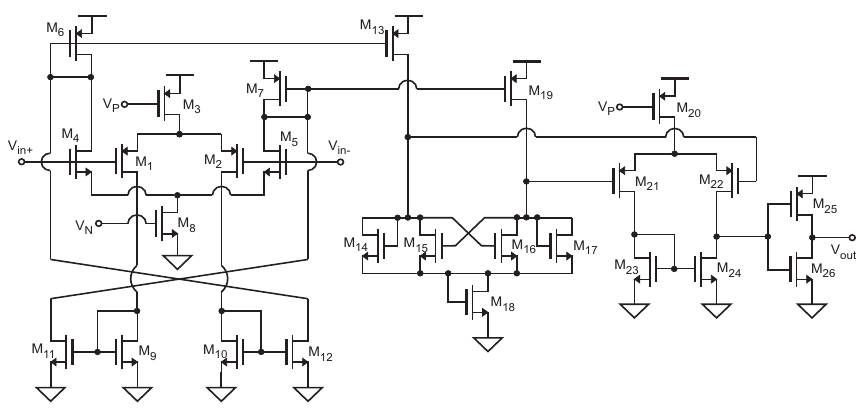
Figure 6. Implementation at transistor level of the comparator.